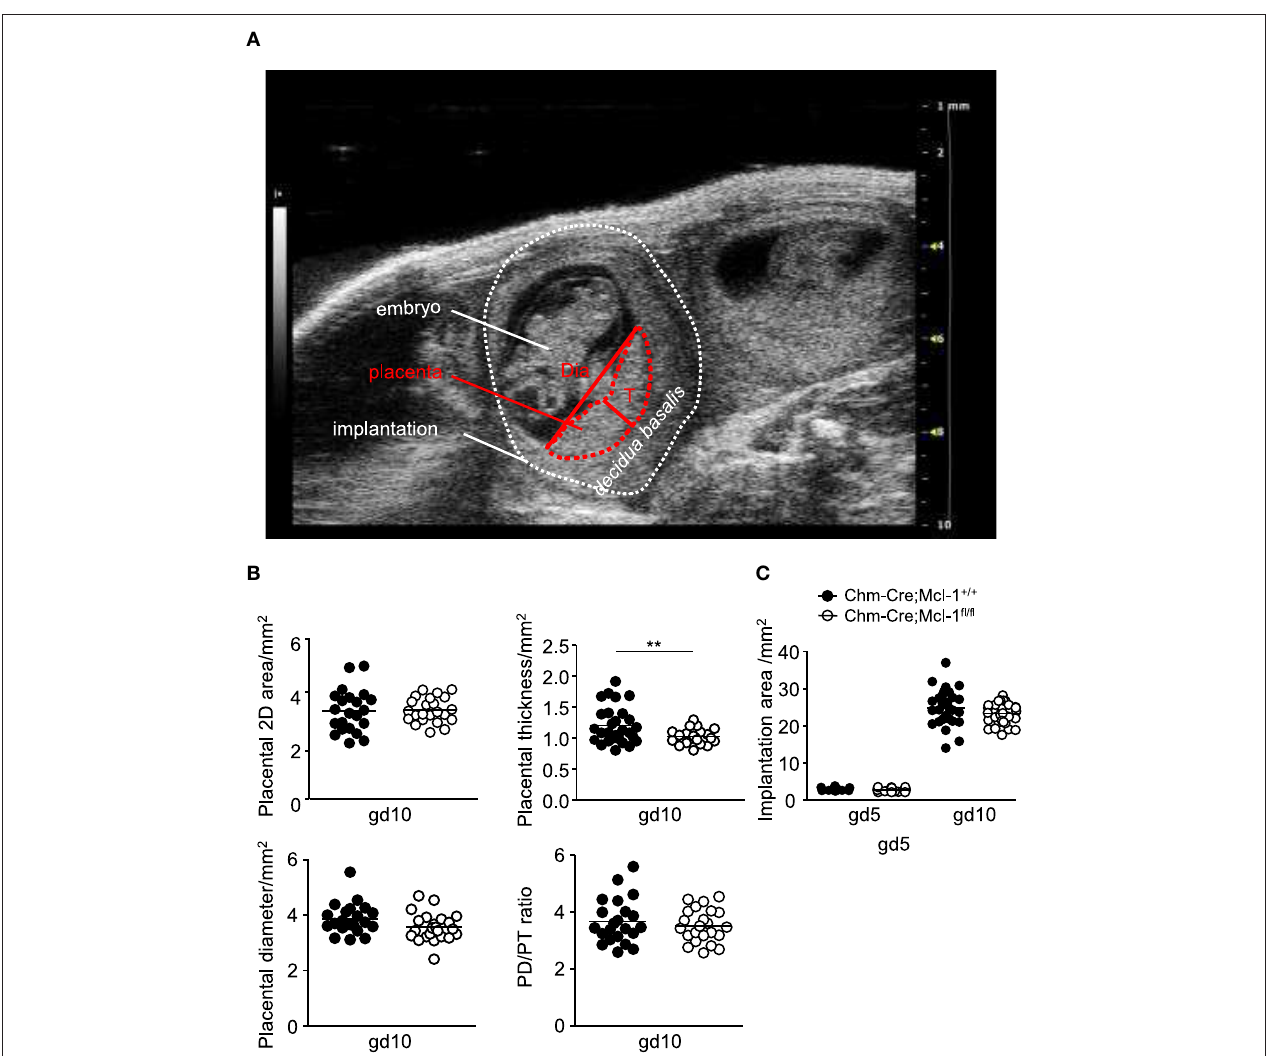
FIGURE 3 | Chm-Cre; Mcl-1 fl / fl mice presented decreased placental thickness at gd10. (A) Representative ultrasound image of an implantation at gd10 showing the embryo, the decidua basalis , and the placenta with placenta thickness (T) and diameter (Dia). (B) Placental area, placental thickness, placental diameter, and placental diameter/thickness ratio from Balb/c-paired Chm-Cre; Mcl-1 + / + (mice n = 4, placentas n = 22) and Chm-Cre; Mcl-1 fl / fl mice (mice n = 5, placentas n = 23) at gd10. (C) Implantation areas in mm 2 from Balb/c-paired Chm-Cre; Mcl-1 + / + (mice n = 4, implantations n = 15–32 per day) and Chm-Cre; Mcl-1 fl / fl females (mice n = 5, implantations n = 21–36 per day) at gd5 and gd10. Results are presented as individual values for each single placenta with mean. Statistical differences were obtained using unpaired t -test (** P < 0.01). gd, gestation day; T, thickness; Dia, diameter.